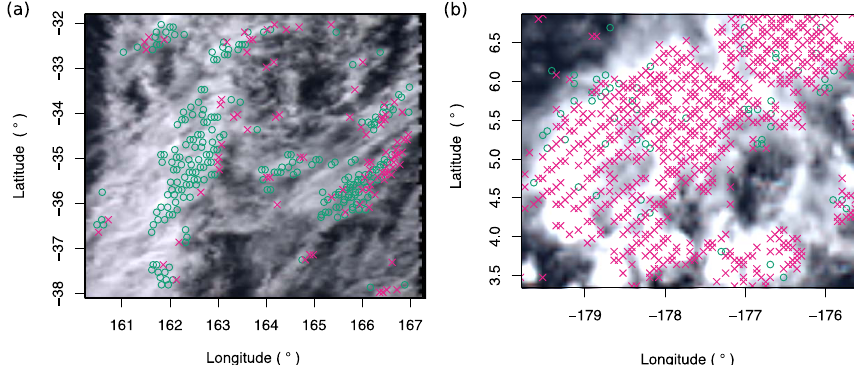
Figure 16. Comparison of (a) a typical cloud scene in the extratropics and (b) a cloud scene in the tropics where the χ 2 values are much larger than expected. Green circles are inference locations where the χ 2 value is less than the 95th percentile of the χ 2 distribution, whereas magenta crosses are inference locations where the χ 2 value exceeds the 95th percentile. These figures indicate that the causes of a large χ 2 value may be different in the extratropics and tropics.